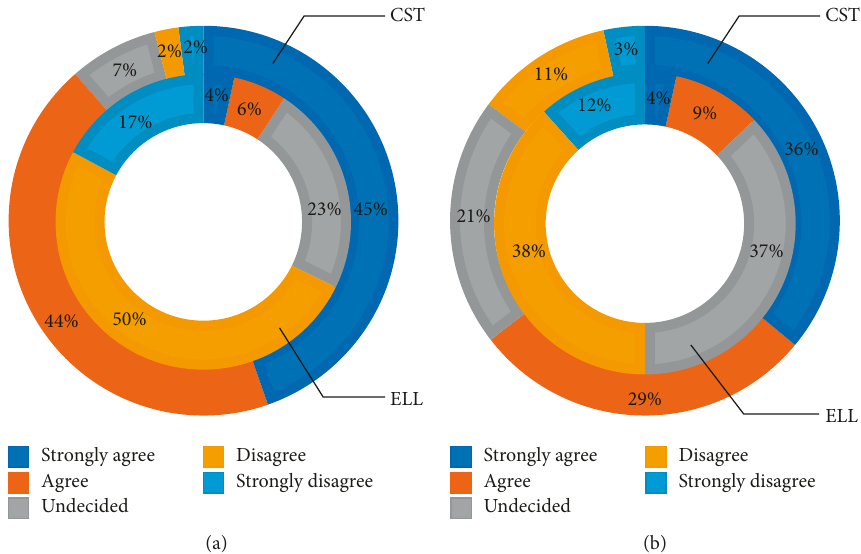
Figure 4: Learner reflections. Technical proficiency with ICE: (a) online learning platform (OLP) and (b) operate online assessment system (OAS).